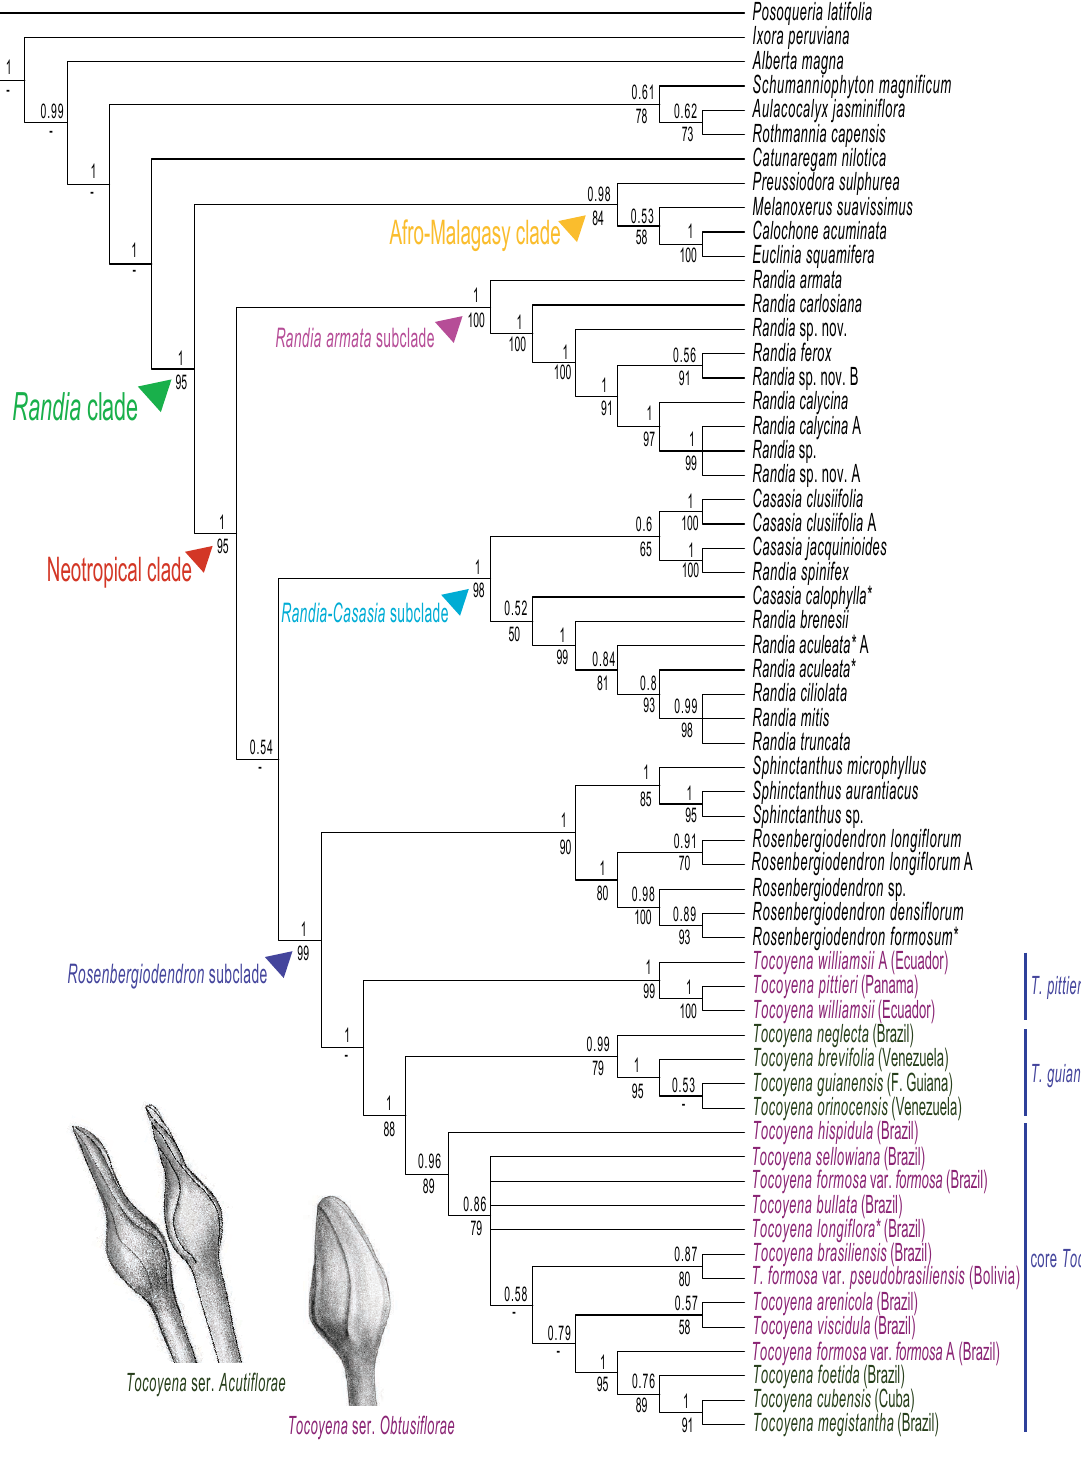
Figure 1 – Cladogram resulting from the Bayesian analysis of nuclear and plastid data (ETS, Xdh , petB-petD , and trnT-F ) with support values (PP above and BS below the branches). BS < 50% are indicated by a hyphen (-). Taxa marked with an asterisk (*) denote type species of the genera in the Neotropical clade of the Randia clade. Clade names in colour are discussed in the text. The species included in the current (non-monophyletic) subgeneric classification of Tocoyena (i.e. T. ser. Acutiflorae and T. ser. Obtusiflorae sensu Schumann 1891, Silberbauer- Gottsberger et al. 1992, and Gottsberger et al. 2020) are indicated in green and purple, respectively, together with drawings that show the botanical basis for the serial division (following Schumann 1891). The countries from which the samples of Tocoyena were collected are indicated in parenthesis after the taxon name. Illustrations by Natanael